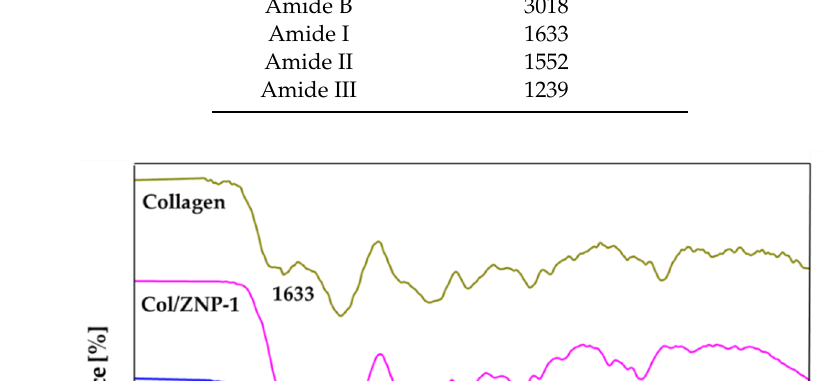
Table 1. Characteristic collagen bands in FTIR spectra.